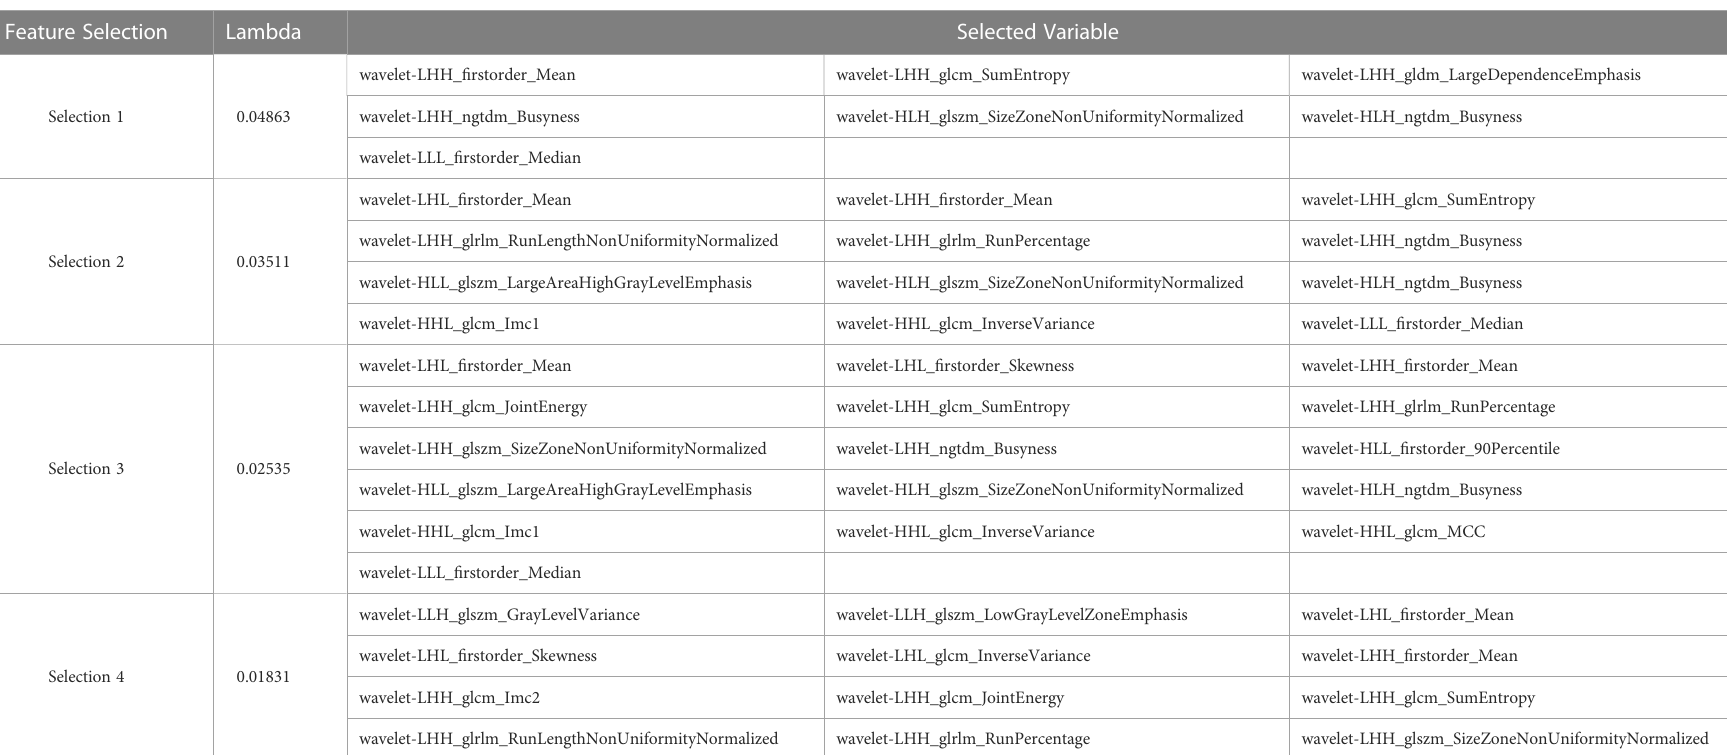
TABLE 3 Top fi ve variable feature selection performed by Lasso Logistic Regression at various lambda value using